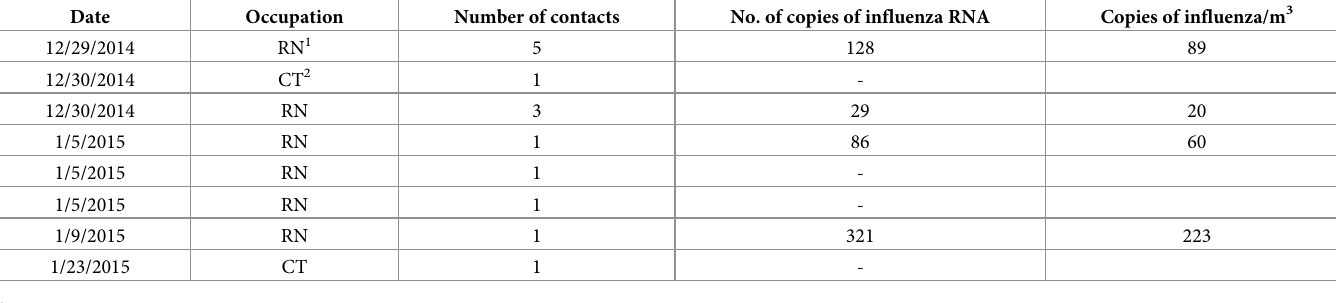
Table 5. Personal bioaerosol sample results of participants that had contact with influenza positive